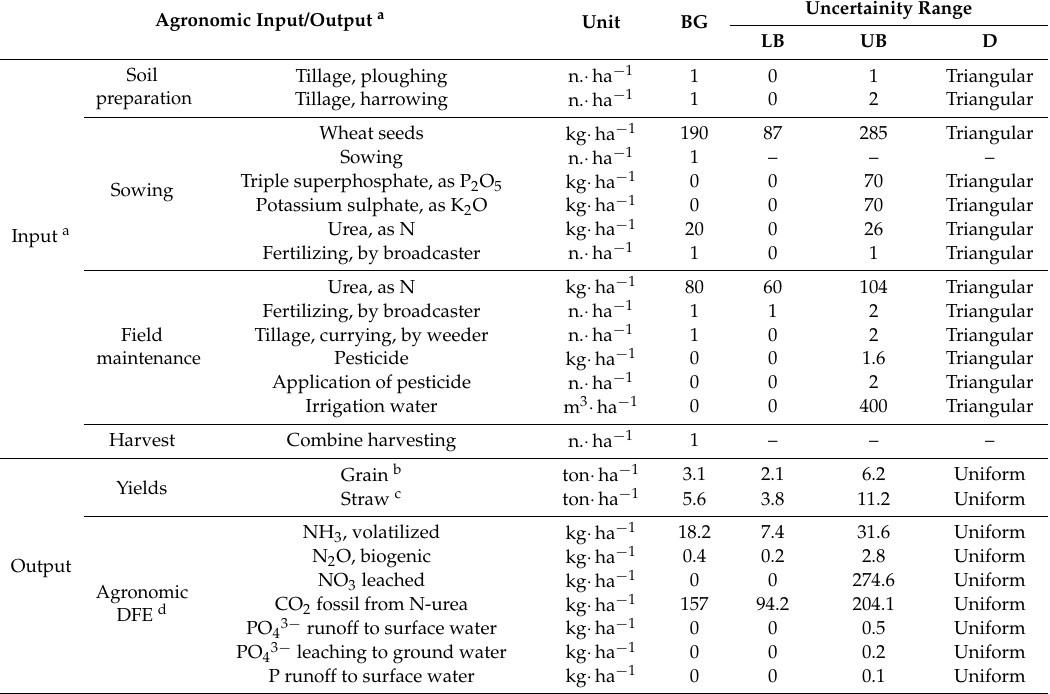
Table 1. Best guess (BG) for agronomic input and output of wheat cultivation. Lower and upper bounds (LB and UB, respectively) of uncertainty range and type of applied distribution (D) are also